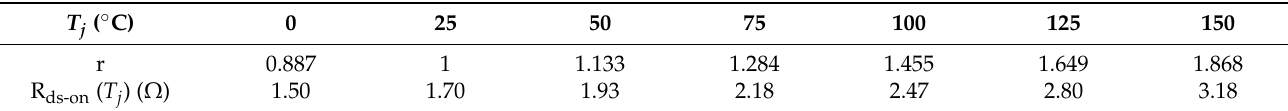
Table 1. Points extracted from the data sheet.